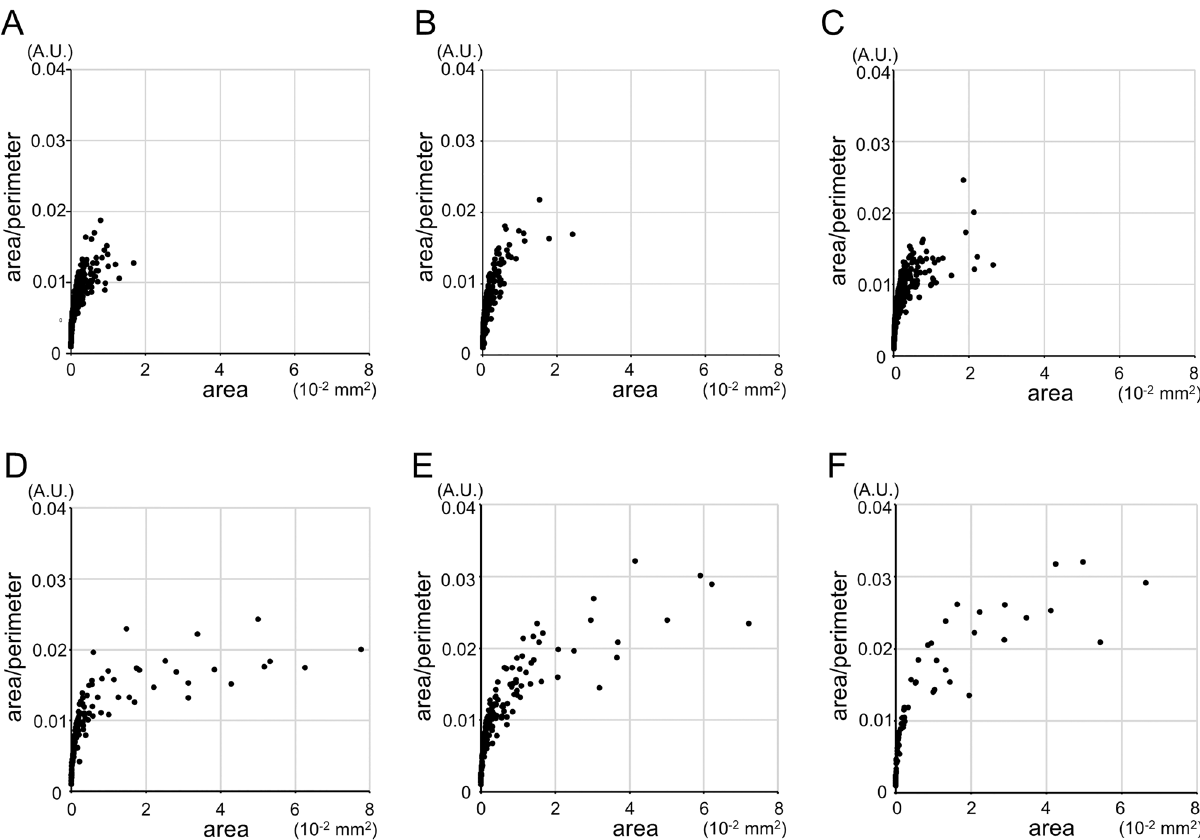
Figure 5. Intercapillary spaces with higher area/perimeter ratios or larger areas in representative cases with referable DR. The intercapillary spaces are small and have low area/perimeter ratios in a representative eye of a nondiabetic subject ( A ), with no apparent retinopathy ( B ), and with mild NPDR ( C ). ( D ) An eye with moderate NPDR had larger intercapillary spaces than the aforementioned groups. ( E , F ) An eye with severe NPDR or